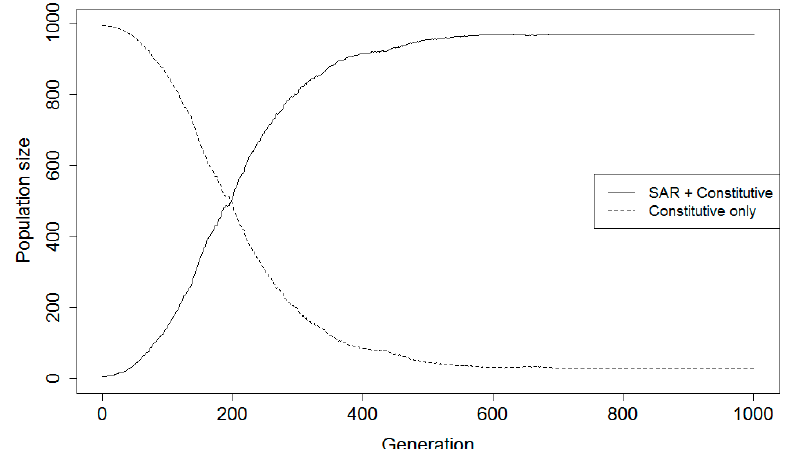
Figure 3. Example projections for averages of 100 simulation runs of a game theory model simulating hypothetical plant populations with (SAR + Constitutive) or without (Constitutive only) the capability for systemic acquired resistance (complementary resistance strategies) over 1000 generations when disease certainty was 40%, the probability for a priming false positive was 40%, and the probability for a false negative was 20%.